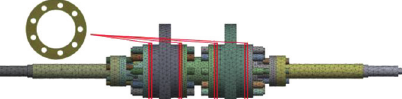
Figure 6: Modal testing results of Case 1: modal damping ratio versus preload on M16 bolt.